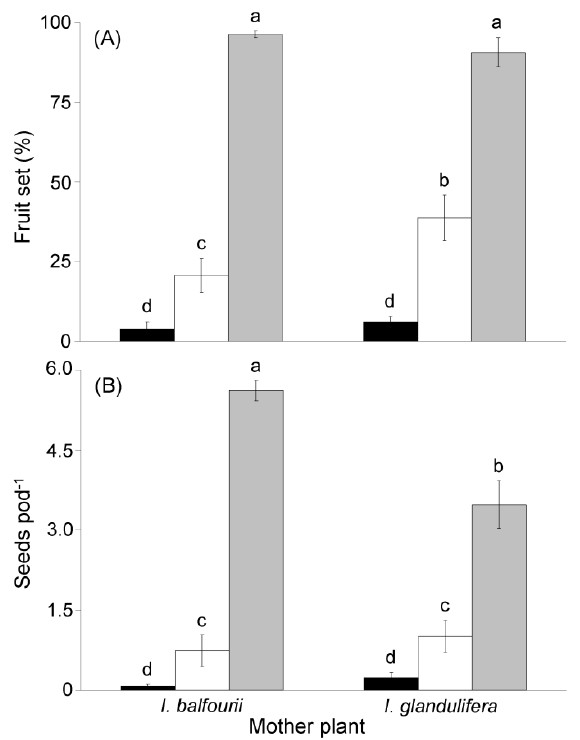
F IG . 2. Mean (± SE) fruit (A) and seed (B) production following pollen exclusion (black bars, treatments B0 and G0), interspecific crosses (white bars, treatments B×G and G×B) and conspecific crosses (grey bars, treatments B×B and G×G). Letters above columns in the same graph indicate significant differences among types of cross (Sequential Bonferroni test, P <